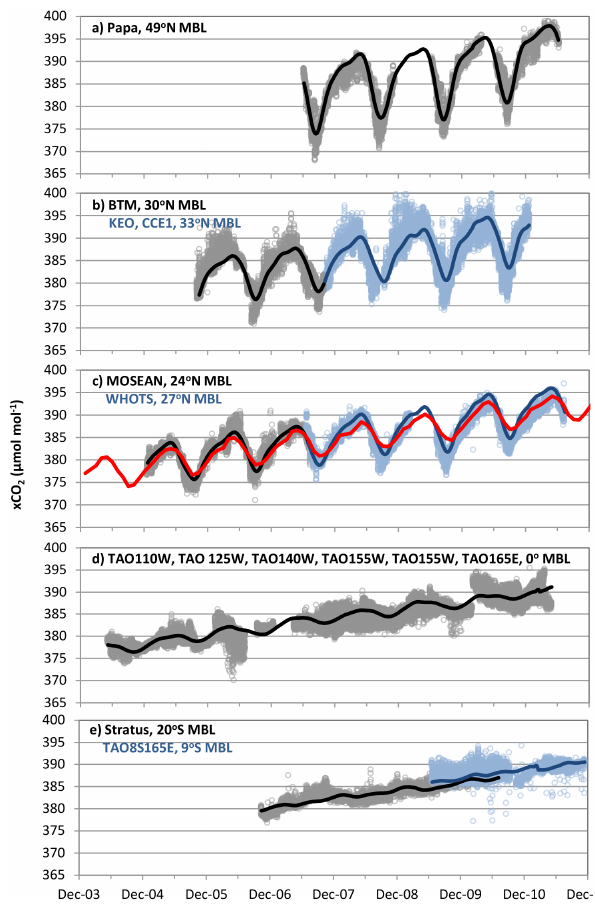
Figure 4. MAPCO 2 and GLOBALVIEW-CO2 MBL atmo- spheric x CO 2 (µmol mol − 1 ) presented by latitude: (a) Papa MAPCO 2 (gray points) and MBL at 49 ◦ N (black line); (b) BTM MAPCO 2 (gray points) and MBL at 30 ◦ N (black line), KEO and CCE1 MAPCO 2 (blue points) and MBL at 33 ◦ N (blue line); (c) MOSEAN MAPCO 2 (gray points) and MBL at 24 ◦ N (black line), WHOTS MAPCO 2 (blue points) and MBL at 27 ◦ N (blue line), and Mauna Loa Observatory atmospheric x CO 2 (red line); (d) six equatorial MAPCO 2 buoys (gray points) and MBL at 0 ◦ (black line); and (e) Stratus MAPCO 2 (gray points) and MBL at 20 ◦ S (black line), TAO8S165E MAPCO 2 (blue points) and MBL at 9 ◦ S (blue line). MBL data from GLOBALVIEW- CO2 (2013). Mauna Loa Observatory monthly mean data from Pieter Tans, NOAA/ESRL (http://www.esrl.noaa.gov/gmd/ccgg/ trends/), and Ralph Keeling, Scripps Institution of Oceanography (http://scrippsco2.ucsd.edu/).